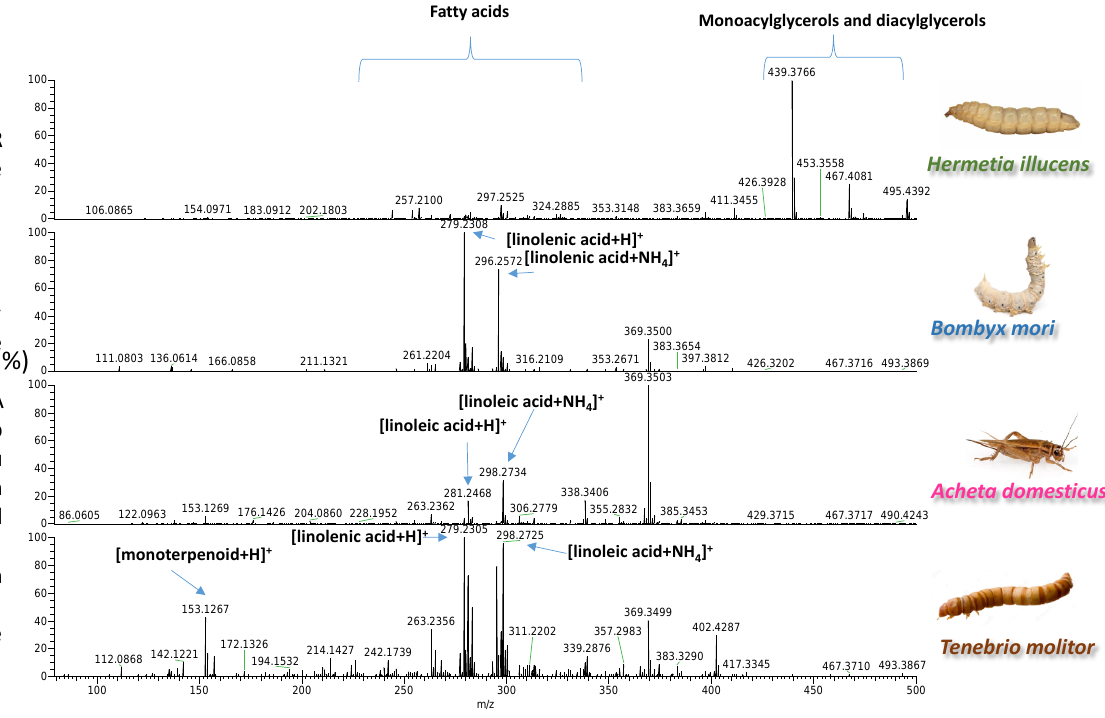
Figure 2. DART-HRMS spectra of the extracts B of edible powders of Hermetia illucens , Bombyx mori , Acheta domesticus , and Tenebrio molitor acquired in positive ion mode. The acquired spectra are zoomed in, to facilitate the visualization of the most informative m/z range between 75 – 500 Da.